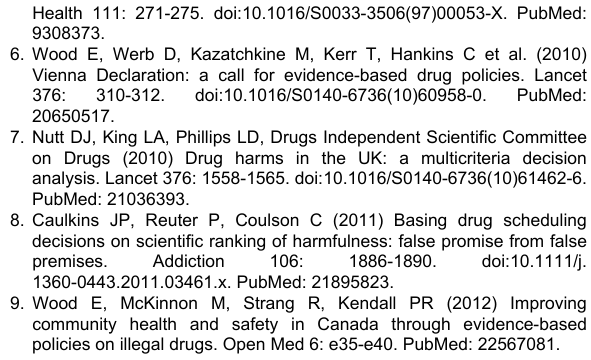
Table S1. Validation of self-reported drug use by urine drug screen in baseline month (n=270). Table S2. Clinical measures of multimorbidity. Table S3. Regression analysis between Composite Harm Score and health outcome measures in